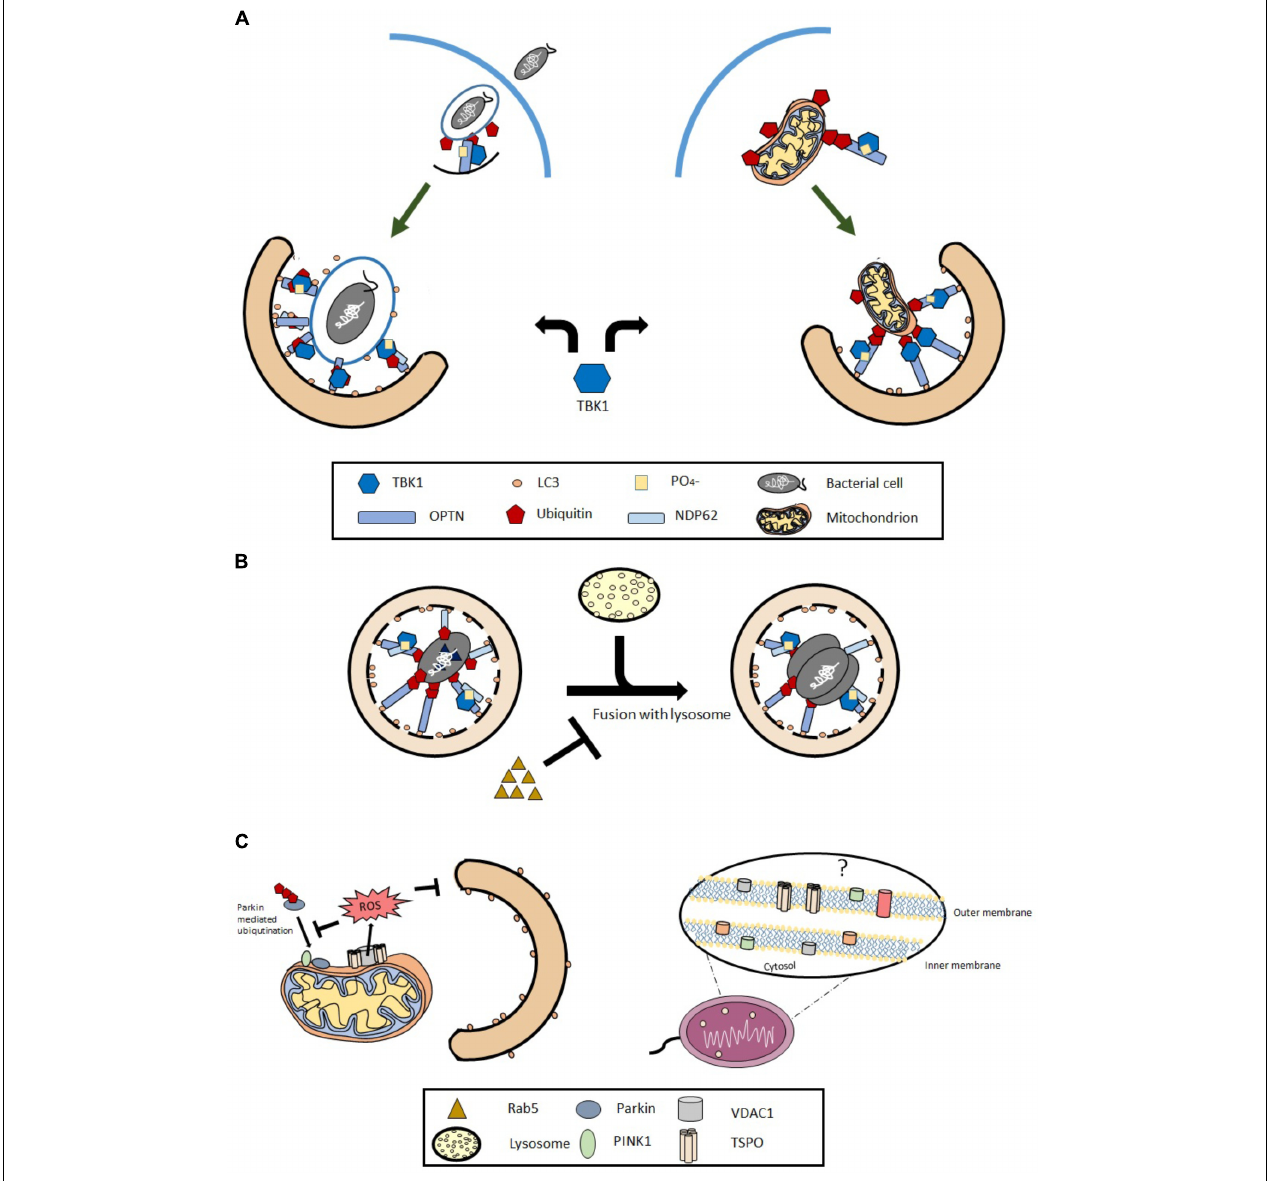
FIGURE 1 | Tank-binding kinase 1 (TBK1) as a common functional element between Xenophagy and Mitophagy. Panel (A) depicts pivotal steps in the two processes of selective autophagy against pathogens and mitochondria in which TBK1 plays an equally important role. Panel (B) highlights instead that the similarity may embrace also inhibitory mechanisms among which the TSPO pathway is proposed (C)